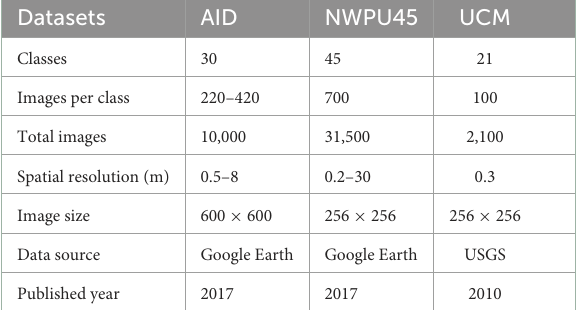
TABLE 1 Datasets